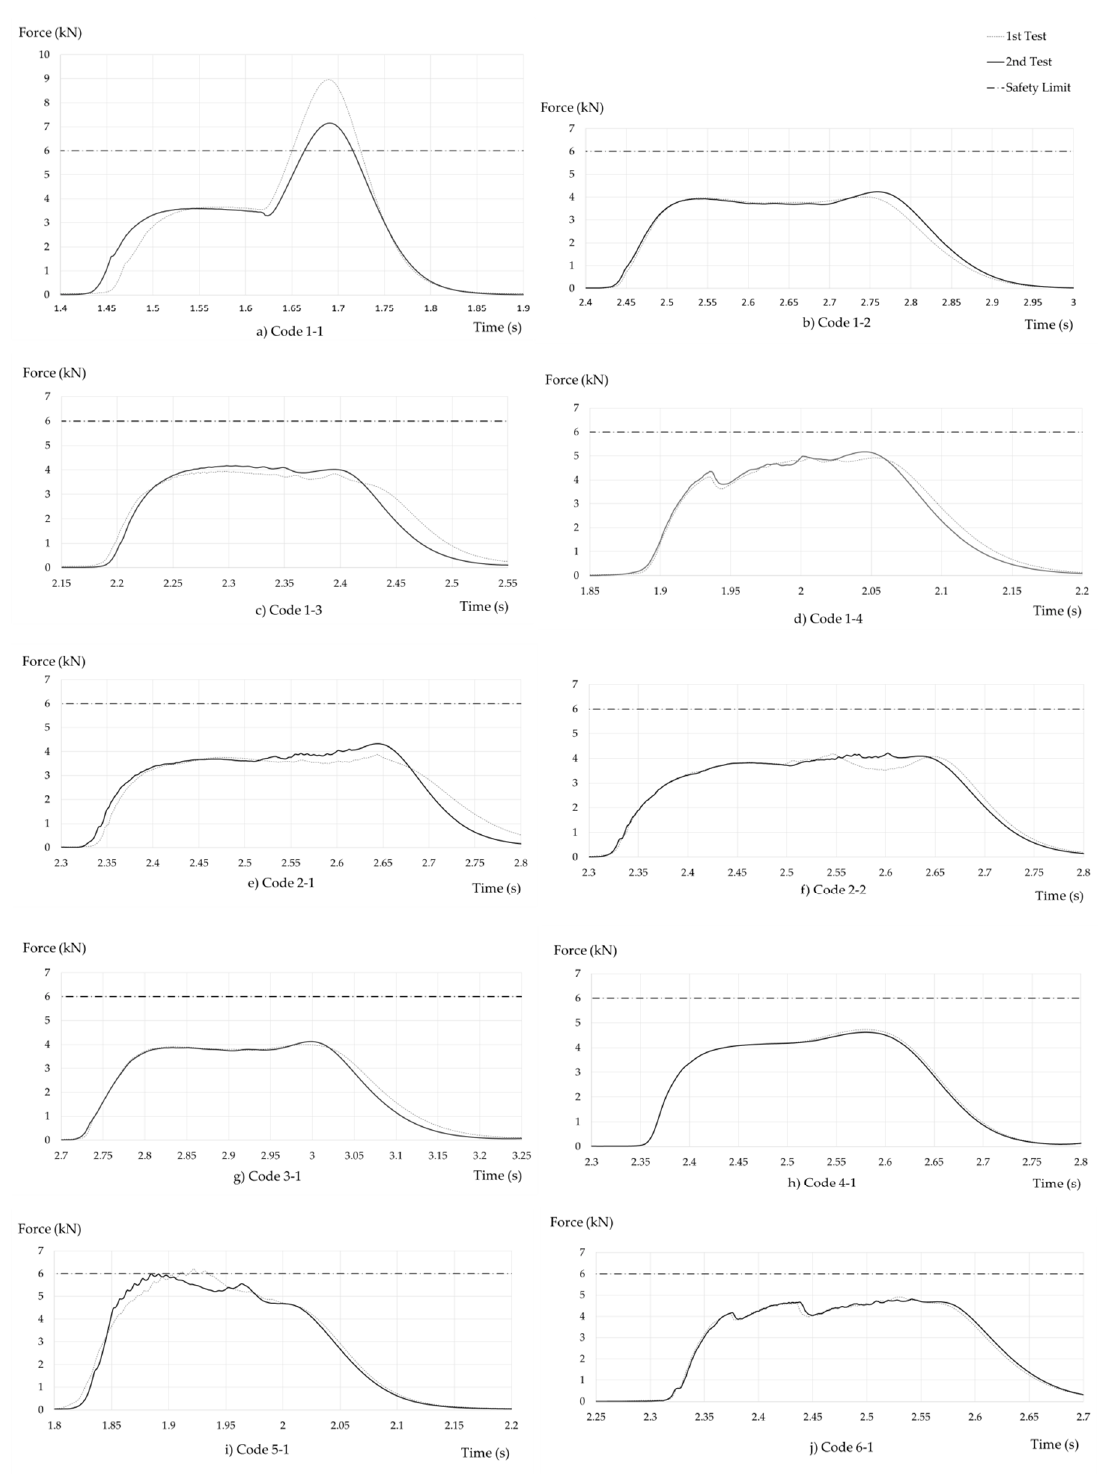
Figure 8. Time–force charts.